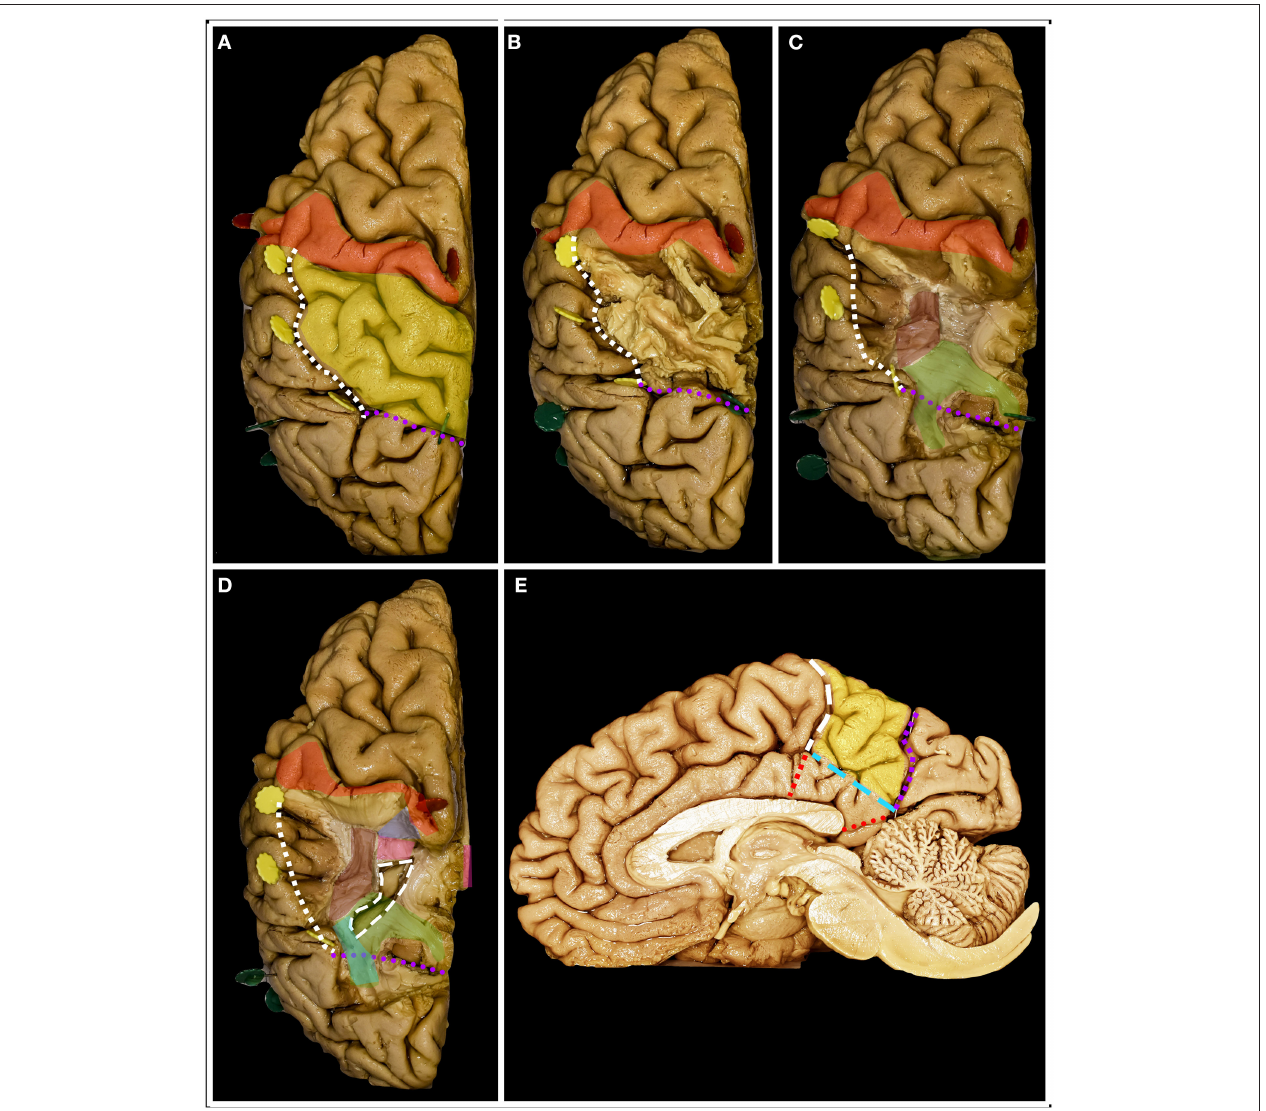
FIGURE 5 | The figure represents the surgical perspective of the surgical field within the superior parietal lobule from a superior perspective. (A) The SPL is located posterior to the postcentral gyrus (red), mesial to the intraparietal sulcus (white square outline), anterior to the parietotemporal line (purple dots) and lateral to the interhemispheric fissure. (B) The most superficial system of the fibers is constituted by the u-fibers connecting the neighboring gyri going at the bottom of the fissures, which are quite deep in this region, reaching up to the gyrus cinguli. (C) Removal of the u-fibers laterally reveals the fibers of the AF/SLF complex (burgundy), which in this case were located mesial to the anterior part of the IPS. Posteriorly and deeper to the AF/SLF fibers of the corona radiata (green) is identified. (D) Mesial the most medial fibers of the AF/SLF complex, the atrium and the occipital horn (white rectangular outline) of the lateral ventricle are identified. The lateral ventricle was identified at the level of the corpus callosum (pink). Anteriorly at the level of the postcentral gyrus, the fibers going medial and deeper than the AF/SLF complex are the thalamocortical fibers (blue). Posterior to the vertical segment of the AF/SLF complex, on the lateral wall of the atrium and occipital horn of the lateral ventricle, the SS is identified. (E) On the mesial surface, the precuneus (yellow) constitutes the mesial part of the SPL. The resection line can be performed along the well-defined parieto-occipital (purple square outline) sulcus posteriorly and marginal ramus of the cingulate sulcus (white rectangular outline) anteriorly. The anatomical inferior border of the resection is set by the subparietal sulcus (light blue rectangle line) or surgical sulcus on the corpus callosum along the line being extension of the marginal ramus (red square line) and of the calcarine sulcus through the isthmus (red